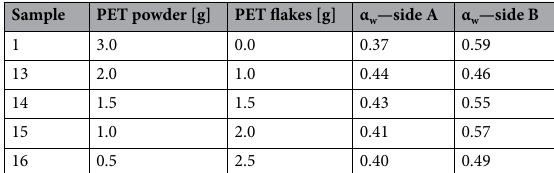
Table 11. Averaged sound absorption coefficient for different combinations of microplastic powder and flakes.